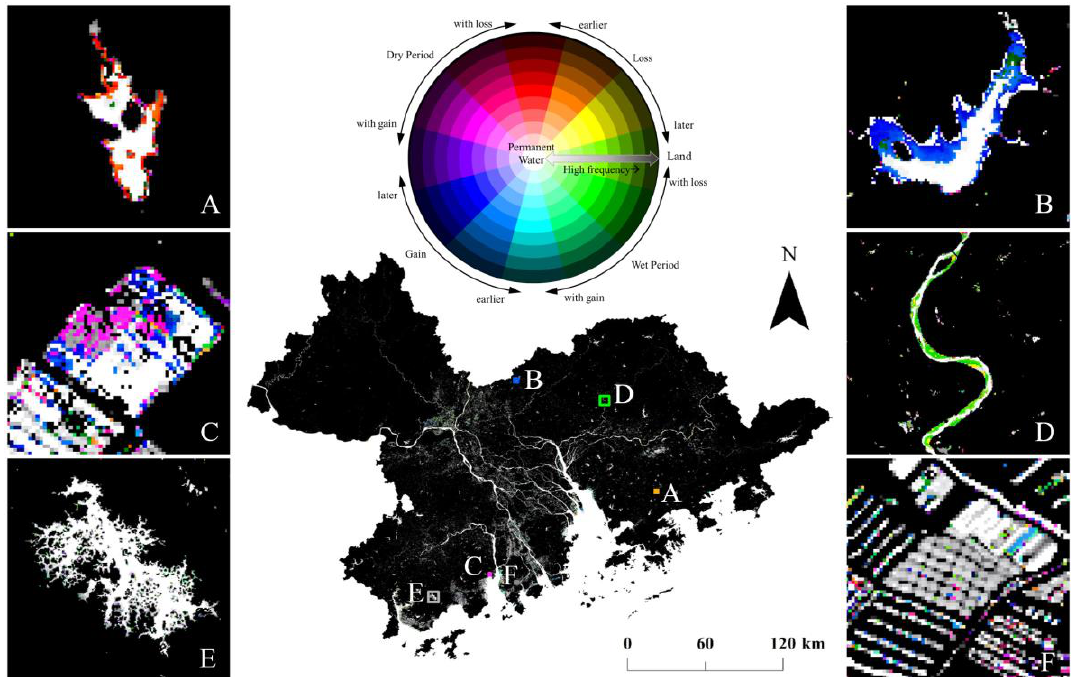
Figure 9. Illustration and typical examples of classes of the water dynamics map. Each example has the annual water inundation frequency time series and corresponding R-G-B reduction for a given 30 m × 30 m pixel. (A – F) represent Loss, Gain, Dry period, Wet period, Stable seasonal and High frequency, respectively.